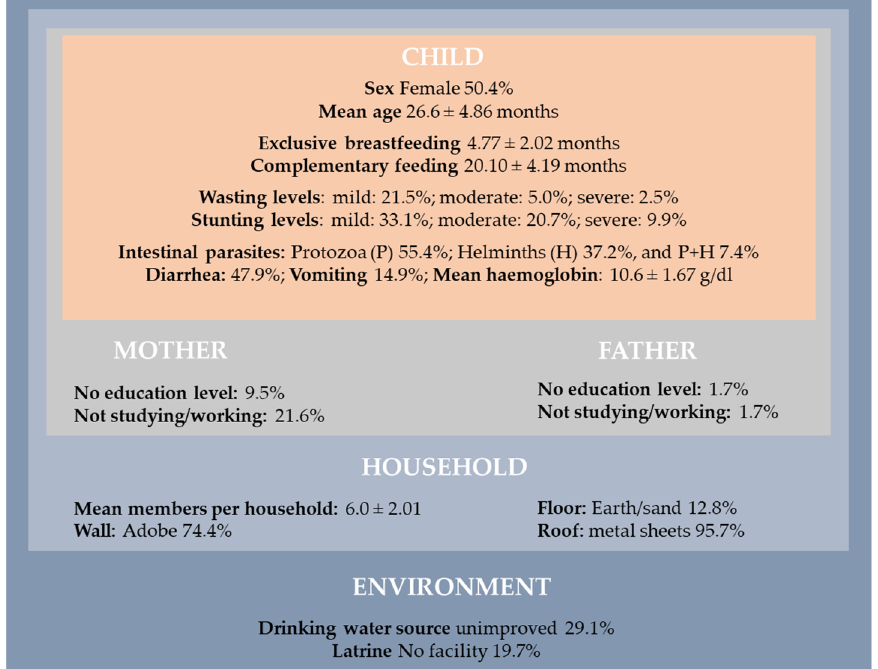
Figure 2. Baseline sociodemographic characteristics, nutritional status, and health conditions of the participants ( n = 121, t = 0).